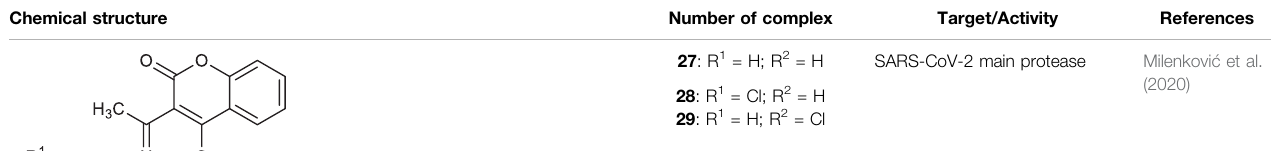
TABLE 1 | ( Continued ) Coumarin-based metal complexes with diverse biological